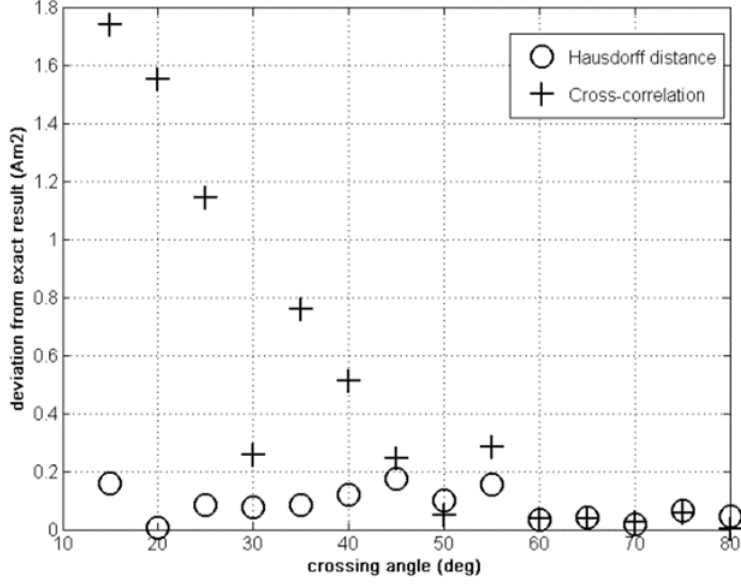
Figure 6. Magnetic moment error: Hausdorff vs. cross correlation